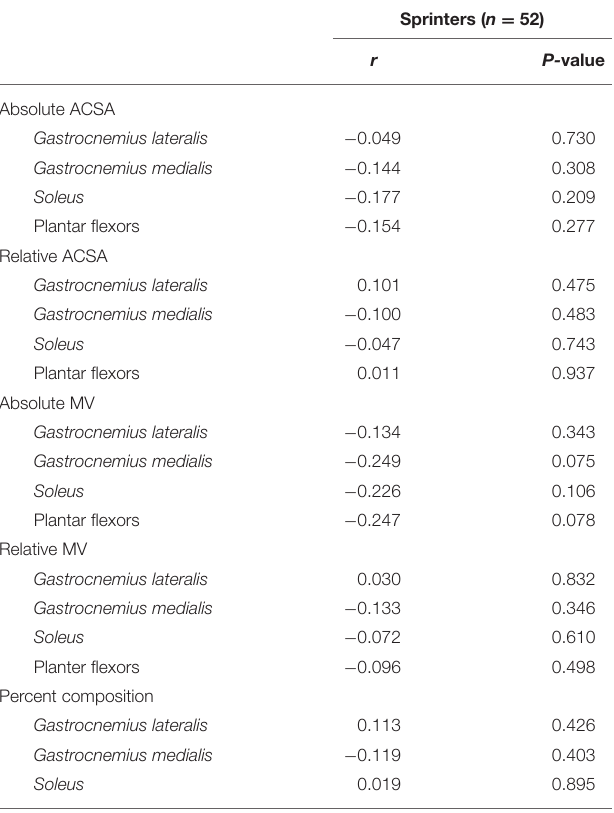
TABLE 3 | Pearson’s product moment correlation coefficients between plantar flexor muscle size variables and personal best 100-m race time in